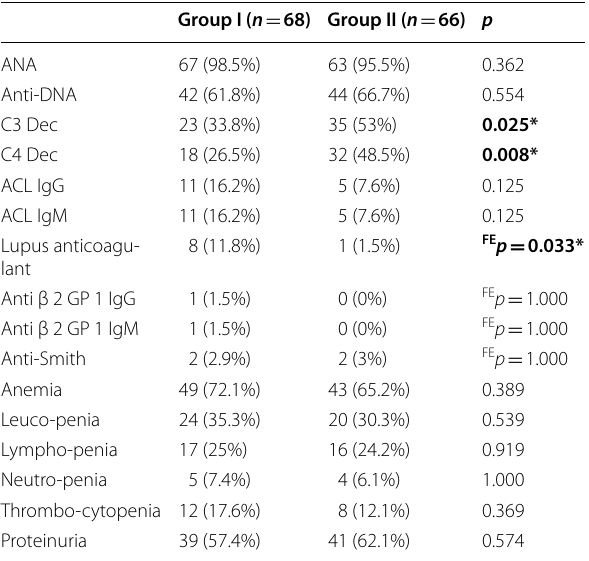
Table 3 Comparison between the studied groups according to laboratory results